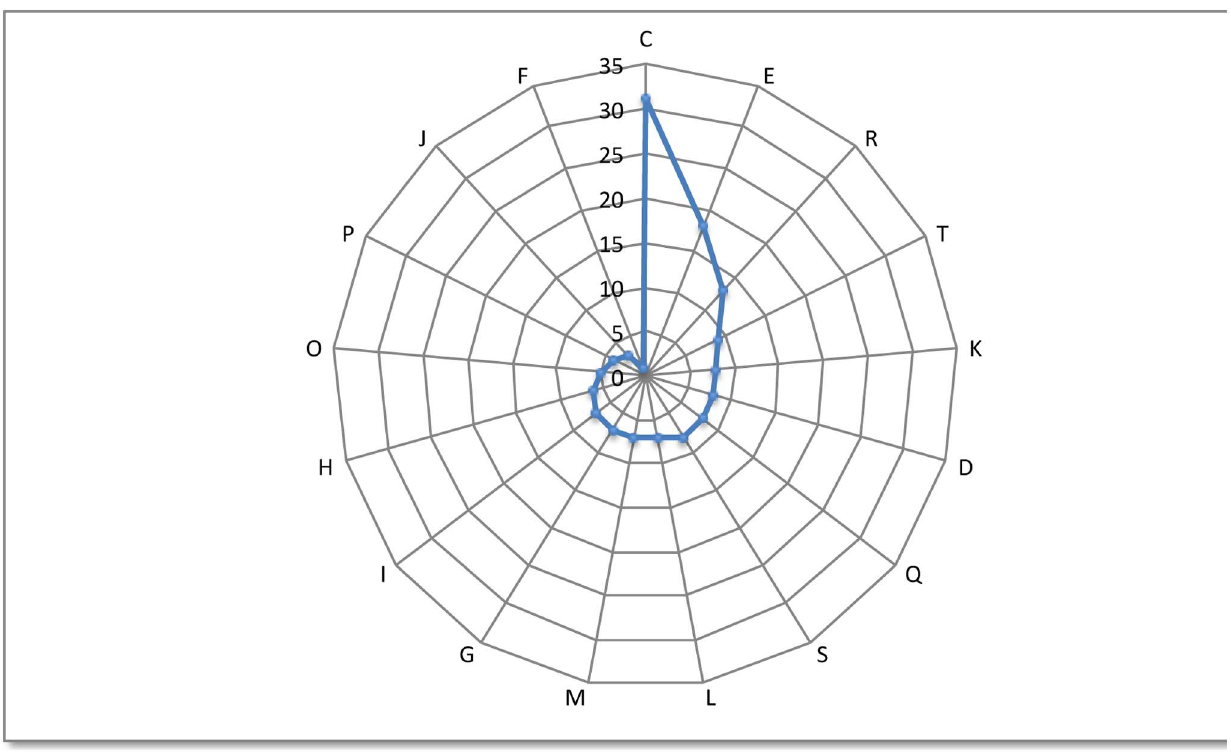
Figure 1. Functional assignment of the metagenomic fosmid clones using the COG database. (C) Energy production and conversion; (E) Amino acid transport and metabolism; (R) General function prediction only. (T) Signal transduction mechanisms; (K) Transcription; (D) Cell cycle control, mitosis, and meiosis; (Q) Secondary metabolites biosynthesis, transport and catabolism; (S) Function unknown; (L) Replication, recombination, and repair; (M) Cell wall/membrane biogenesis; (G) Carbohydrate transport and metabolism; (I) Lipid transport and metabolism; (H) Coenzyme transport and metabolism; (O) Post-translational modification, protein turnover, chaperones; (P) Inorganic ion transport and metabolism; (J) Translation; (F) Nucleotide transport and metabolism.